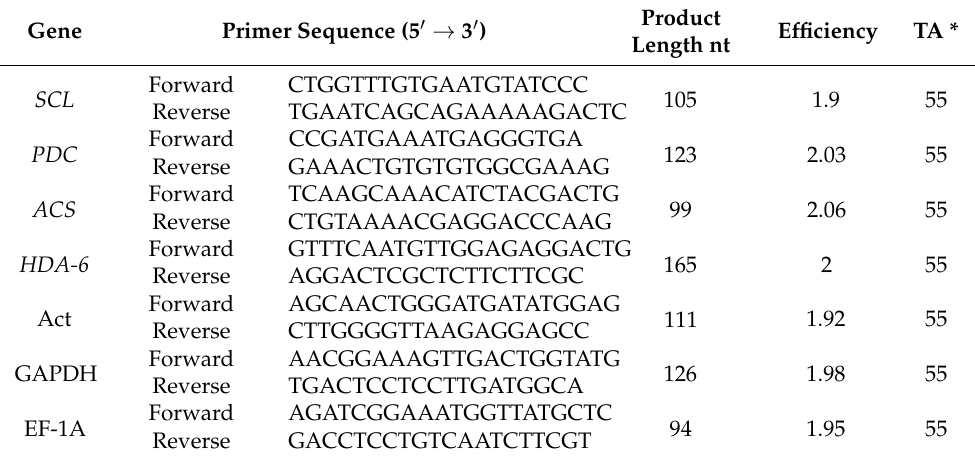
Table 2. Primer sequences for genes used in RT-qPCR and their features.